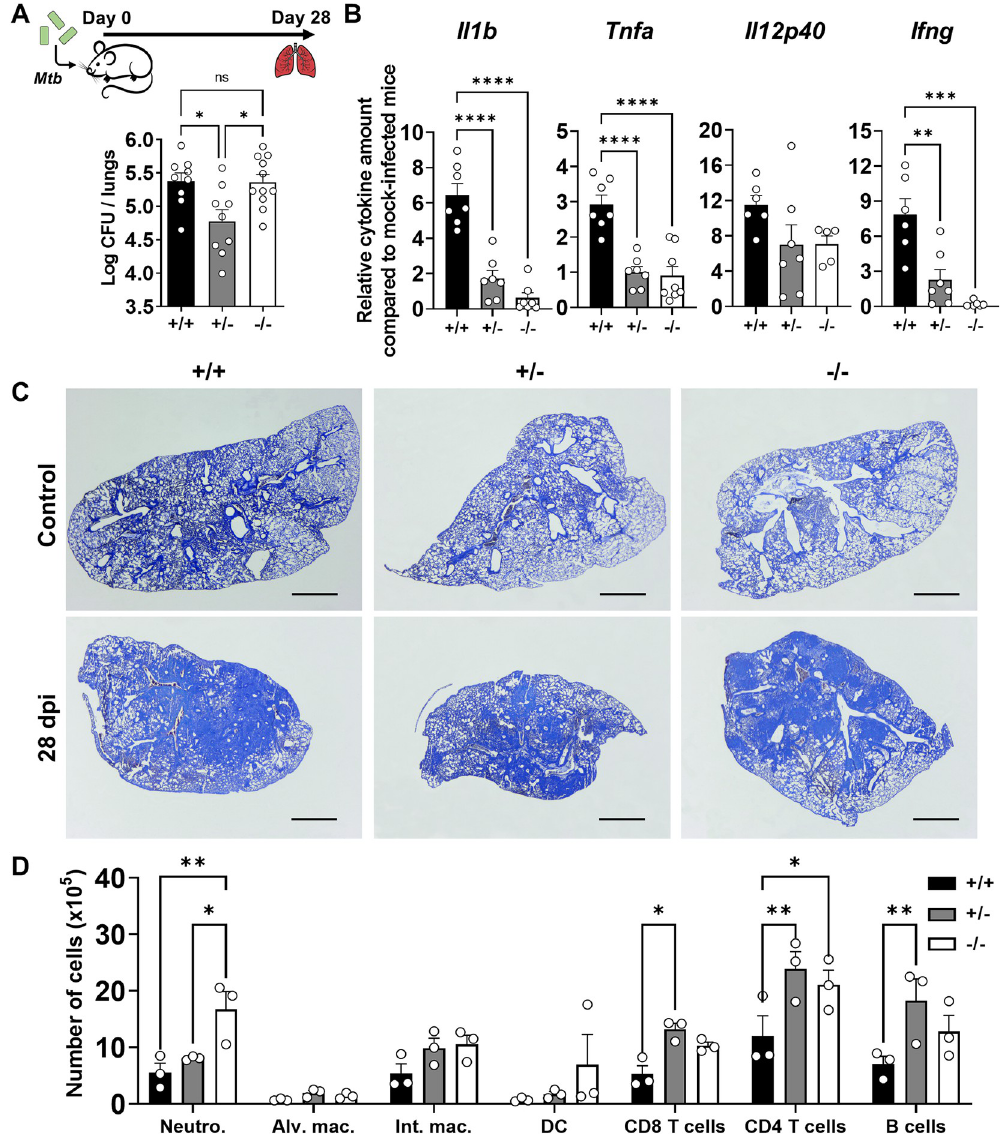
Fig 1. Comparative study of bacterial load, recruited immune cells and cytokine expression in lungs of infected Tirap +/+, +/- and -/- mice. C57BL/6 WT (+/+), Tirap +/- (+/-) and Tirap -/- (-/-) mice were intranasally infected with Mtb H37Rv (10 5 CFU/20 μ L). 28 days post-infection, mice were sacrificed to study their pathological state. ( A ) Mycobacterial load was determined by plating lung lysates and counting Colony-Forming Units (CFU) 2 weeks after plating. Shown are mean ± SEM of at least 9 infected mice per condition of three independent experiments. ( B ) Histograms showing relative cytokine amounts in lung lysates of infected +/+, +/- and -/- mice compared to mock-infected mice. Shown are mean ± SEM of 7 infected mice per condition of one representative out of two independent experiments. ( C ) Toluidine blue staining of non-infected (control) and infected (28 days post-infection) slice lungs (5 μ m) from WT, Tirap +/- and Tirap -/- mice. Bar: 10 mm. ( D ) Histogram depicting changes of immune cells populations during Mtb H37Rv infection, as determined by flow cytometry using specific cell surface markers. Cell numbers were normalized to the total cell number analyzed in the whole lung. Shown are mean ± SEM of cells obtained from three individual mice per group representative of two independent experiments. dpi: days post-infection, ns: non-significant, � P value < 0.05, �� P value < 0.01, as determined by one-way ANOVA